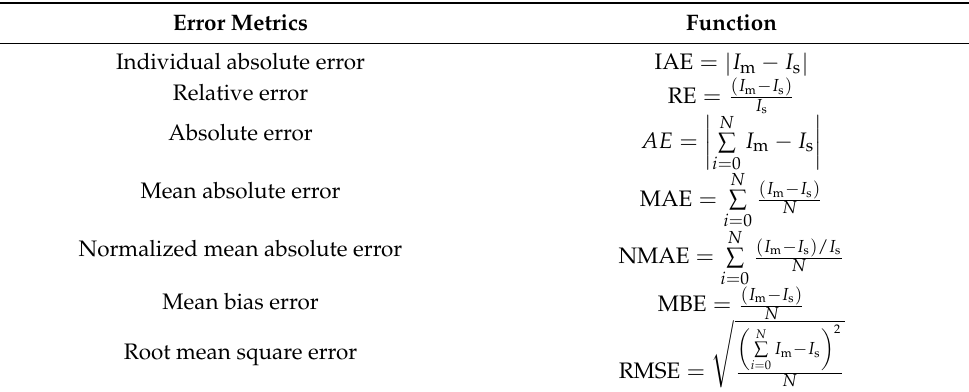
Table 1. Various performance